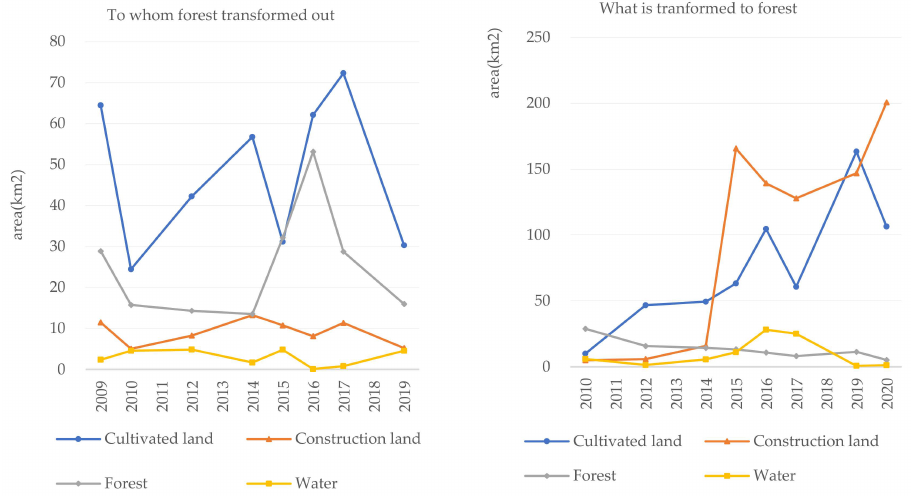
Figure 14. Changes of forest land in the studied